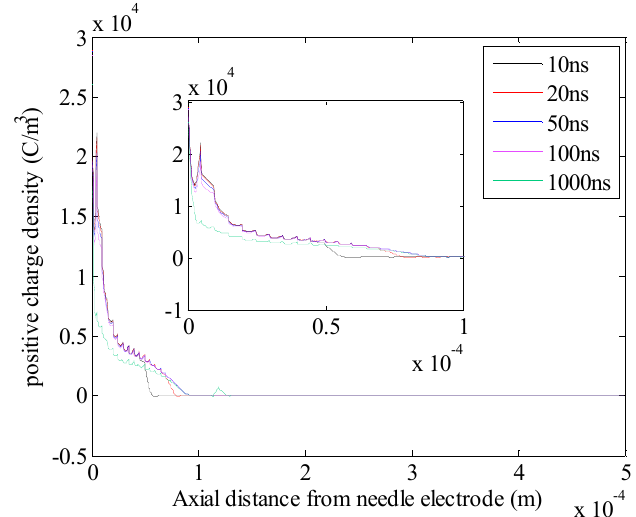
Figure 13. Positive charge density distribution along the needle-sphere axis as a response to 1.5 PDIV with 10 mm needle-sphere electrode